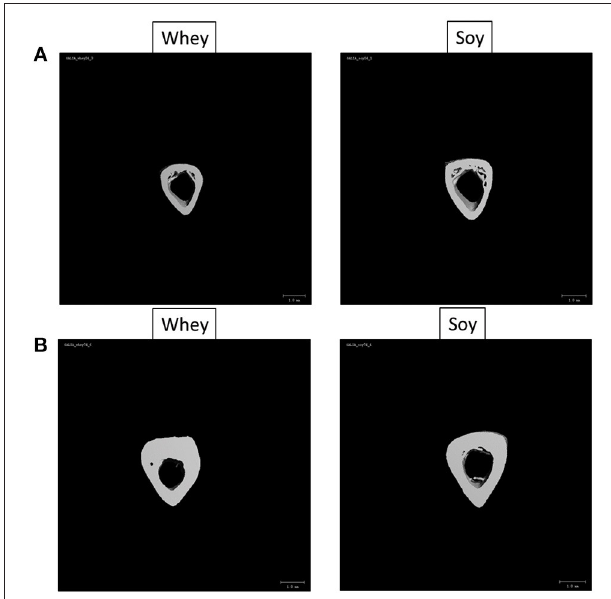
FIGURE 5 | Three-dimensional cortical bone images obtained by µ CT at (A) 24 days or (B) 74 days.